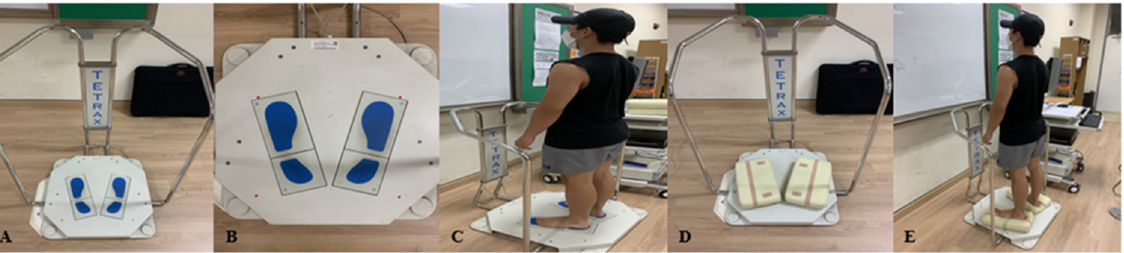
Figure 2. Static balance measurement: ( A ) Tetrax measuring instrument; ( B ) force plate; ( C ) measure on a flat ground; ( D ) unstable ground with a pillow; ( E ) measure on an unstable ground.